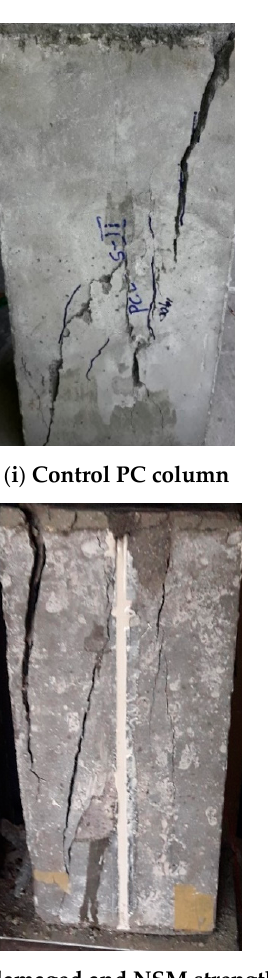
Figure 6. Load - CFRP strain behaviour of FRP strengthened PC columns. Figure 6. Load-CFRP strain behaviour of FRP strengthened PC columns.